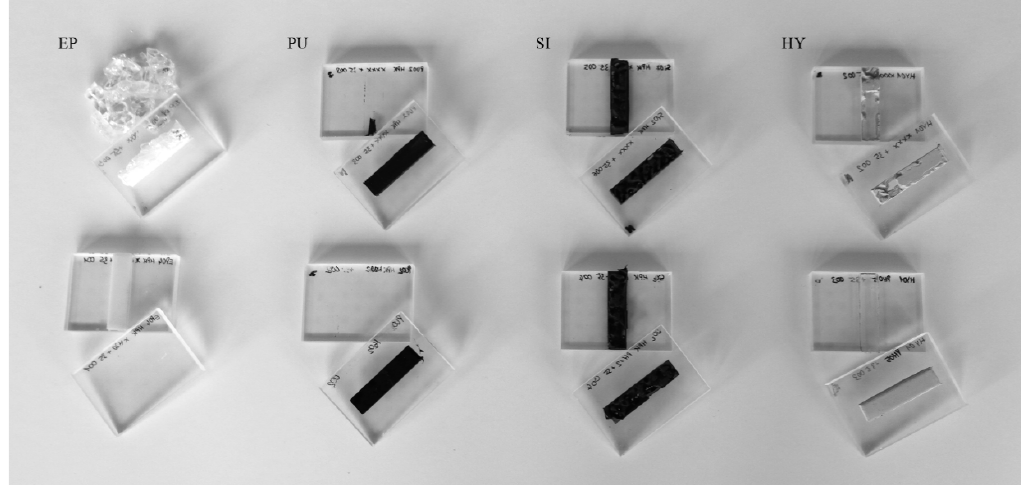
Figure 10: Exemplary failure modes of specimens of the reference series (above) and specimens after chemical aging